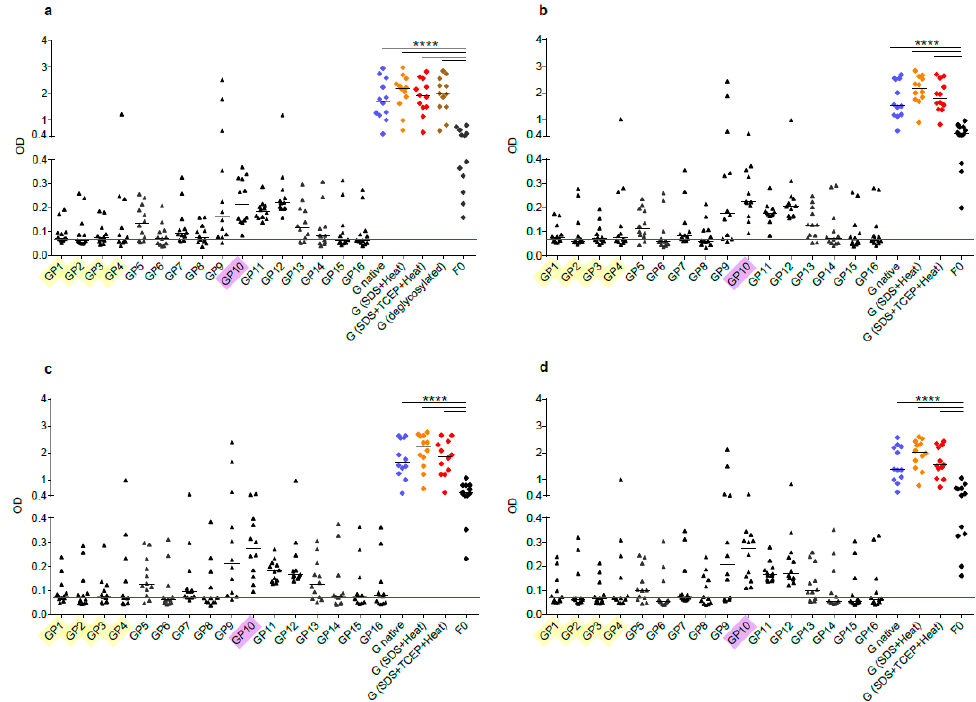
Figure 4. Human antibody responses to recombinant native G, denatured and deglycosylated G and G-derived synthetic peptides. Shown are IgG levels (y-axes: optical density values) in sera from 12 healthy adult individuals obtained at different time points (( a ) January-February; ( b ) April-May; ( c ) August-September; ( d ) January-February next year) to recombinant, native G (blue), G denatured by heat and SDS (orange), G denatured by heat, SDS and TCEP (red), deglycosylated G (only for time point a, brown), G-derived peptides (GP1-GP16; buried peptides: yellow; peptides without glycosylation sites: pink) and recombinant F0 (x-axes). Horizontal lines within scatter plots indicate median values. The cut-off (mean of buffer control plus three times standard deviation) is indicated by horizontal red lines. Significant differences between G and F0-specific antibody levels are indicated (**** p < 0.0001).